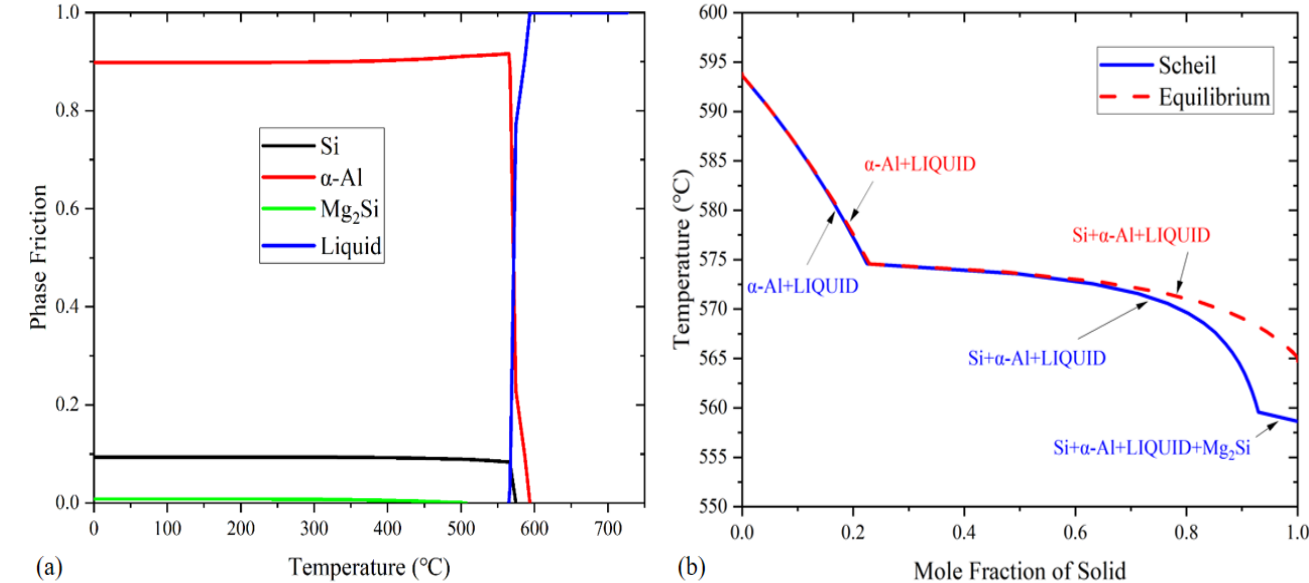
Figure 2. ( a ) Equilibrium solidification phase diagram for Al-10Si-0.48Mg; ( b ) calculated solidification paths for Al-10Si-0.48Mg according to the equilibrium and Scheil schemes.